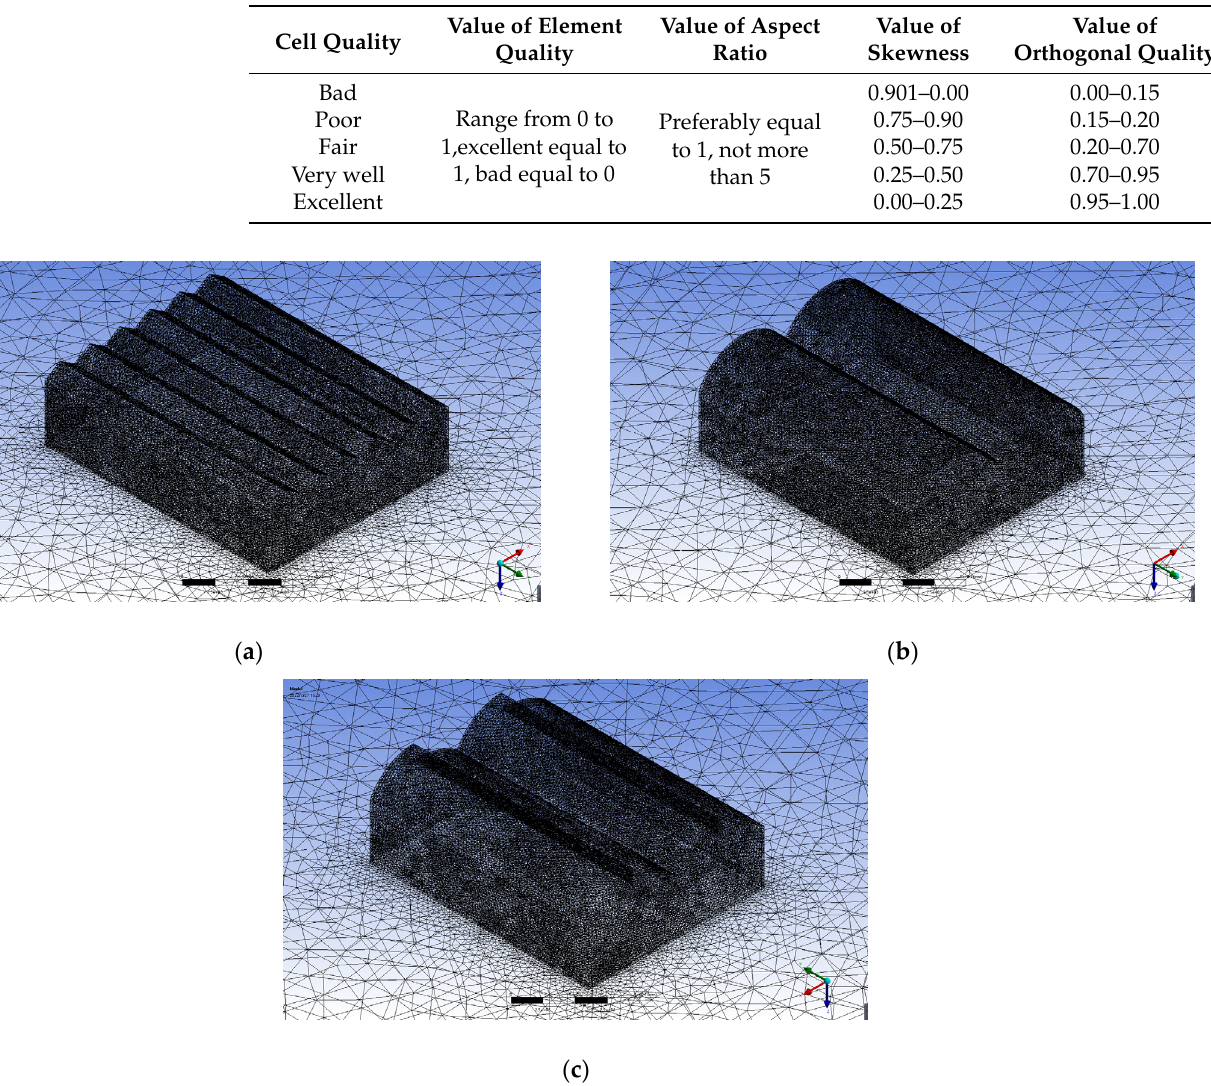
Figure 3. Grid division. ( a )Venlo Type ( b ) Round-arch Type ( c ) Saw-tooth Type.